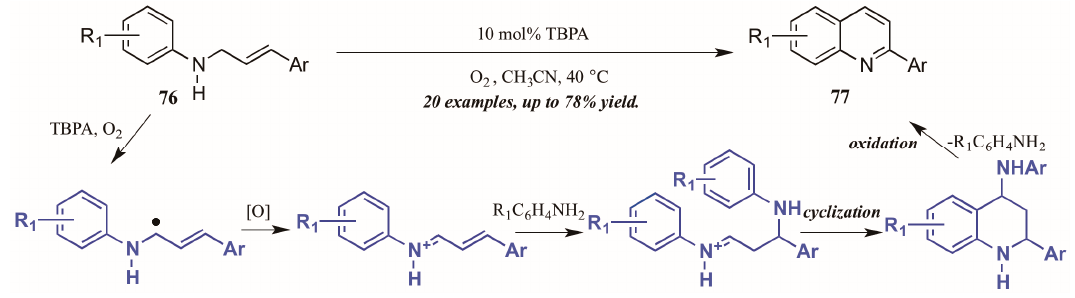
Figure 35. DMSO-mediated oxidative cycloisomerization. 5.3. Aza-Wittig Cascade Reactions The formation of iminophosphoranes, and their subsequent use in aza-Wittig reactions, has become a popular method of nitrogen-heterocycle formation. Shi et al. [49] reported a one-pot, L -proline-catalyzed aza-Wittig cascade reaction resulting in 2- and 3-substituted quinolines (Figure 36). The cascade begins with the Michael addition of the ketone 33 to the β -nitroolefin 80 . A Staudinger reaction of the azide with triphenylphosphine forms the iminophosphorane, which then undergoes aza-Wittig to close the ring. The ring is aromatized with expulsion of nitromethane to give the product quinolines 81 in very good yield.